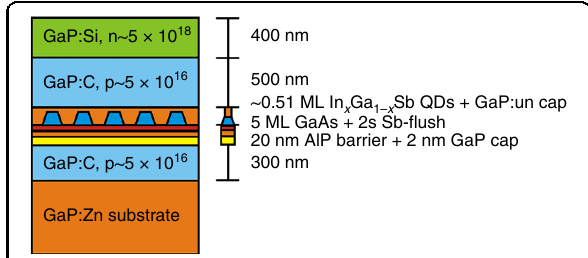
Fig. 10 Schematic structure of the X-STM sample grown by